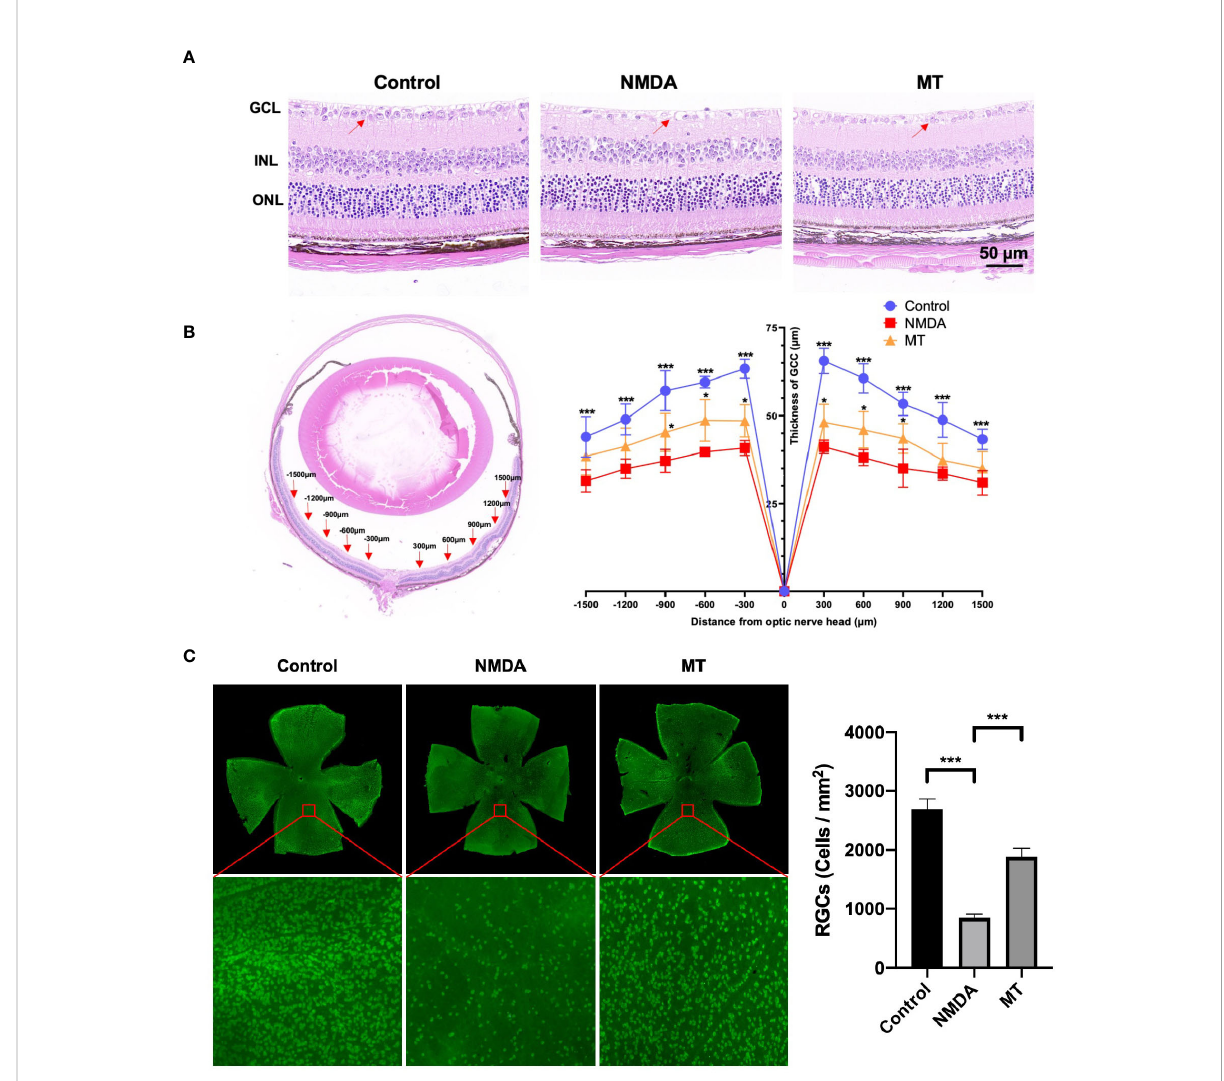
FIGURE 3 MT protects against NMDA-induced retinal damage in mice. (A) Images of H&E staining sections of mice retina at 5 days after intravitreal injection (Scale bar = 50 m m). Red arrows: RGCs. (B) At 5 days after intravitreal injection of NMDA, the GCC thickness of mice was measured ±300, ± 600, ± 900, ±1200, and ±1500 m m away from the optic nerve. (n=4) (C) Labeling of RGCs with RBPMS 5 days after intravitreal injection of NMDA. MT improved the density reduction of NMDA-induced RGC injury in mice (Scale bar = 100 m m). (n=4) Data are the mean ± SD; *p < 0.05, ***p <